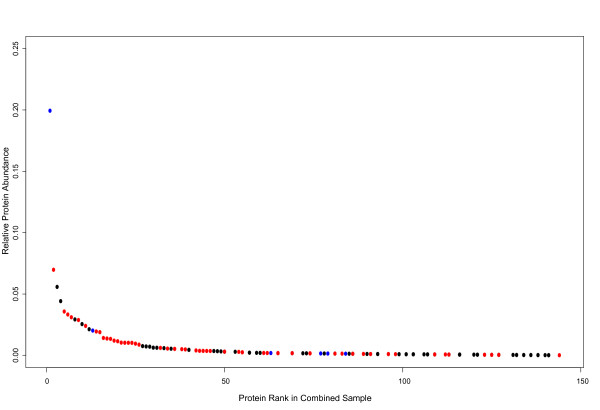
Distribution of protein abundance in D. virilis hemolymph. Plot of ranked protein abundance (see Methods for details) of proteins detected in the hemolymph of D. virilis. Points are coloured based on homology to D. melanogaster and function: red points represent proteins with D. melanogaster homologs that have been reported to be present in D. melanogaster hemolymph, black points represent proteins with D. melanogaster homologs that have not been reported to be present in D. melanogaster hemolymph, and blue points represent proteins without D. melanogaster homologs.